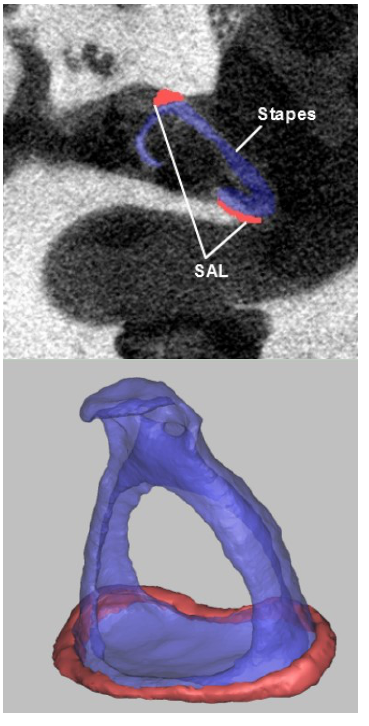
Fig.10. Segmentation of the stapes and the stapedial annular